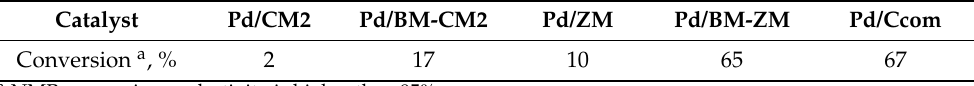
Table 3. Reaction of p-nitrobromobenzene with styrene in the presence of prepared catalysts.